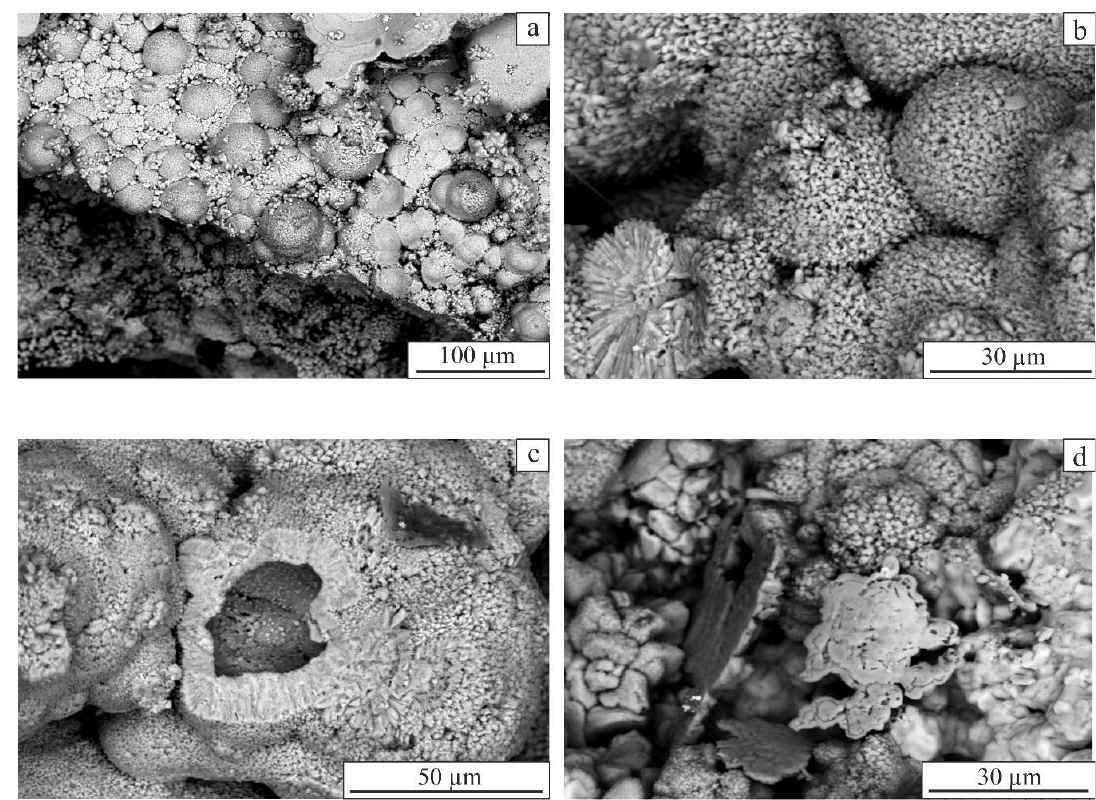
Figure 8. Signs of possible bacterial mineralization of calcite: ( a , b ) spherical aggregates; and ( c , d ) relicts of bacterial films.